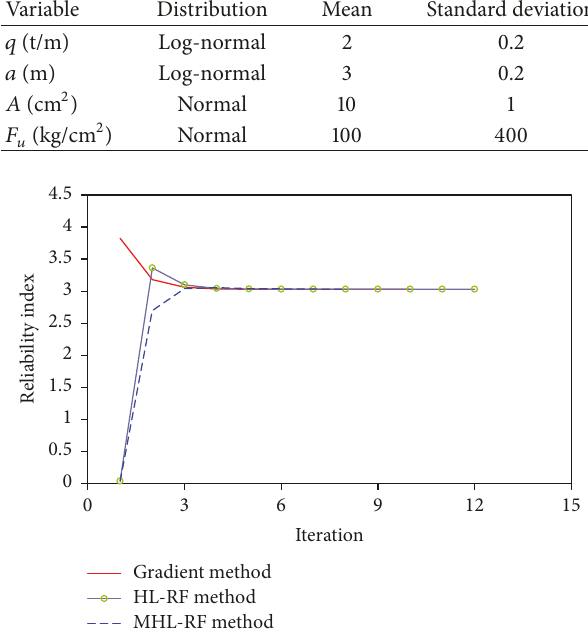
Figure 2: Comparison of reliability history for bar